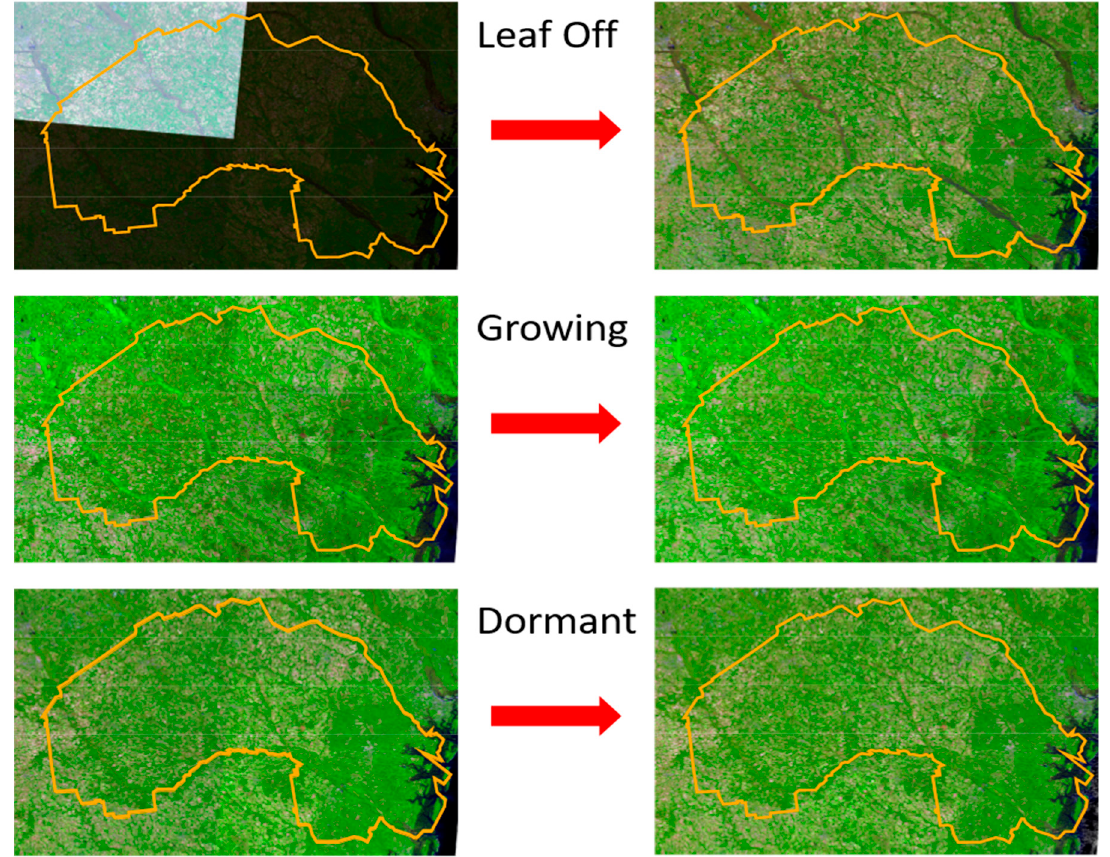
Figure 5. Before aggregate no-change regression (ANR) normalization ( left ) and after ANR normalization ( right ) of Landsat 8 scenes for Leaf off, Growing and Dormant phylogenies. Bands 6, 5 and 4 are displayed here for the extent of the Fort Stewart study area (orange outline) as red, green and blue, color composites with a 2.5 standard deviation color stretch for each four scene mosaic. Pixel values for overlapping region within Landsat 8 images were calculated using the first image value given the order of the mosaicking process (Figure 1).